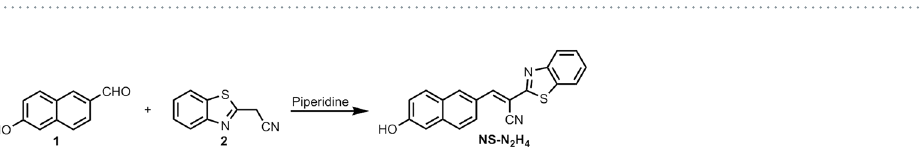
Figure 1. The structure of NS-N 2 H 4 and the proposed sensoring mechanism for N 2 H 4 .